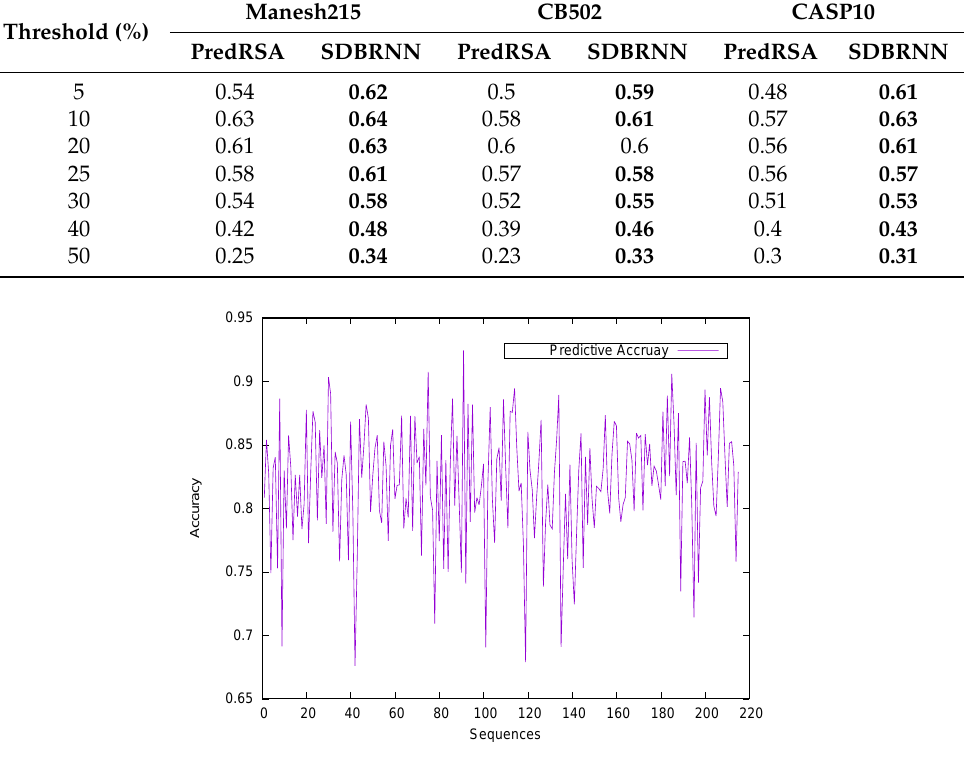
Figure 2. Predicted accuracy on individual sequences from the Manesh215 dataset. The rASA threshold is 25%. Protein sequences are ordered by sequence length.